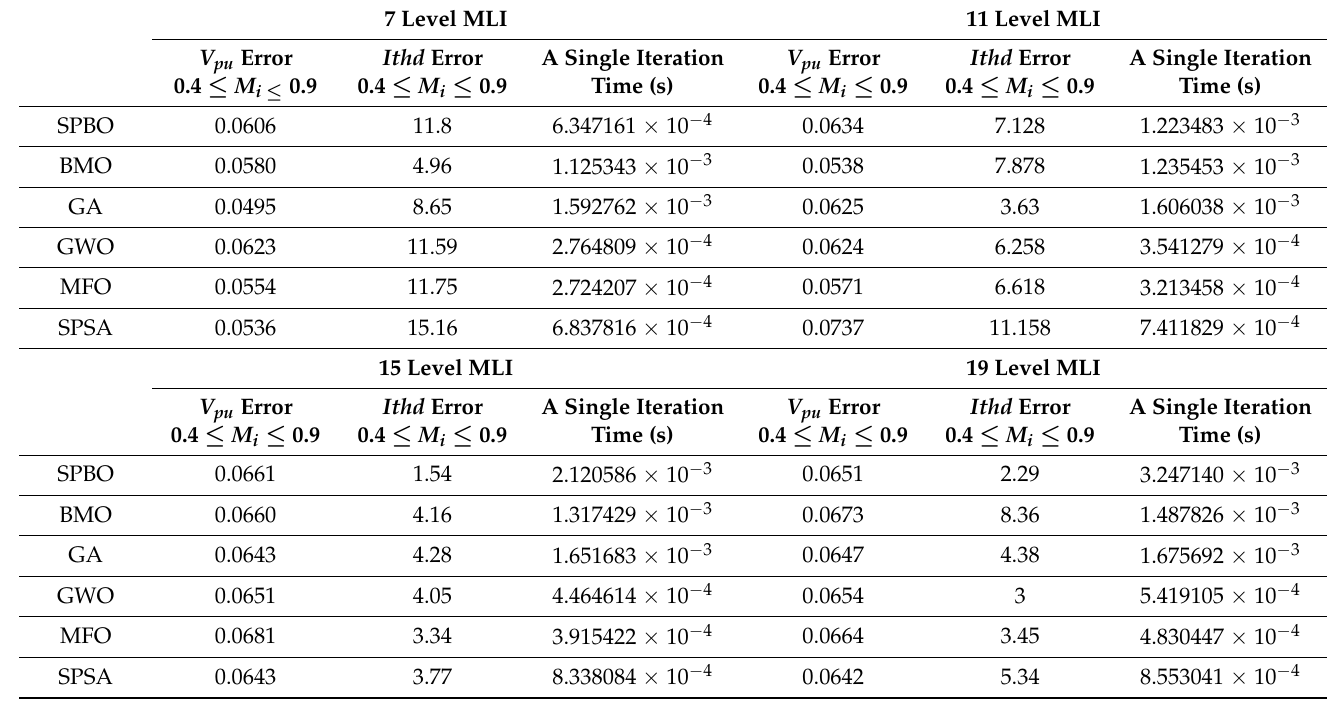
Table 5. Comparison of the error values of the output voltages ( V pu ), the current total harmonic distortions ( Ithd ), and an iteration time in selected algorithms applied to the 7, 11, 15, and 19 levels of MLI. 7 Level MLI 11 Level